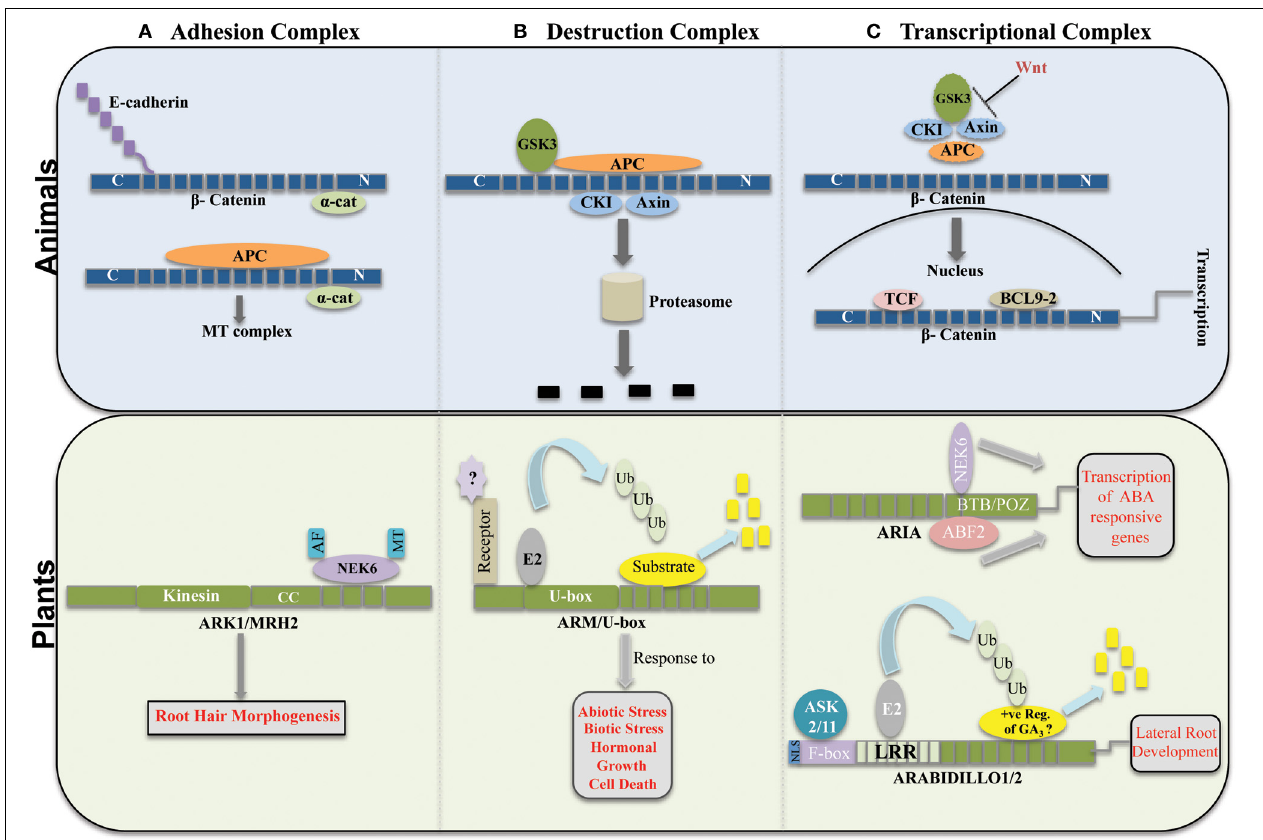
FIGURE 1 | Functional comparison of β -cat like-ARM repeats protein in plants and animals. (A) Adhesion Complex: β -catenin in animals binds cytoplasmic tail of cadherin to link it with α -catenin. Additionally, β -catenin together with APC interacts with microtubule complexes. In plants, ARK1/MRH2 (ARM repeat kinesin1/morphogenesis of root hair 1) interacts with NEK6 (NIMA-related protein kinase 6) to mediate root epidermal cell morphogenesis. CC represent coiled coil domain. (B) Destruction Complex: β -catenin is targeted for proteasomal degradation by a GSK3, APC, CKI, and Axin complex in the cytoplasm. Similarly in plants, ARM/U-box proteins, in